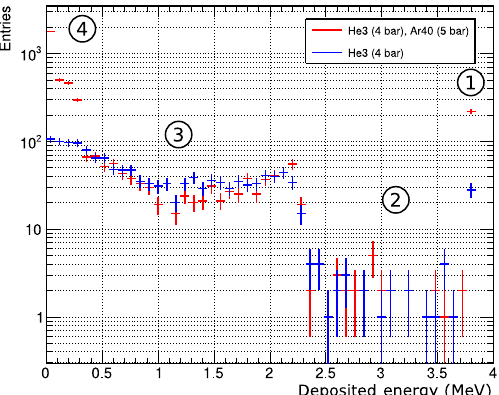
Fig. 4 Simulations of the 3 He proportional counter response to an isotropicmono-energeticneutronfluxof1MeV(left)and3MeV(right). The resulting spectra are shown in two configurations: a pure 3 He gas